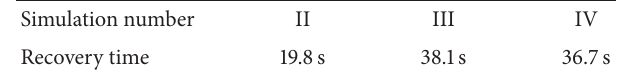
Table 2: The time of recovery from